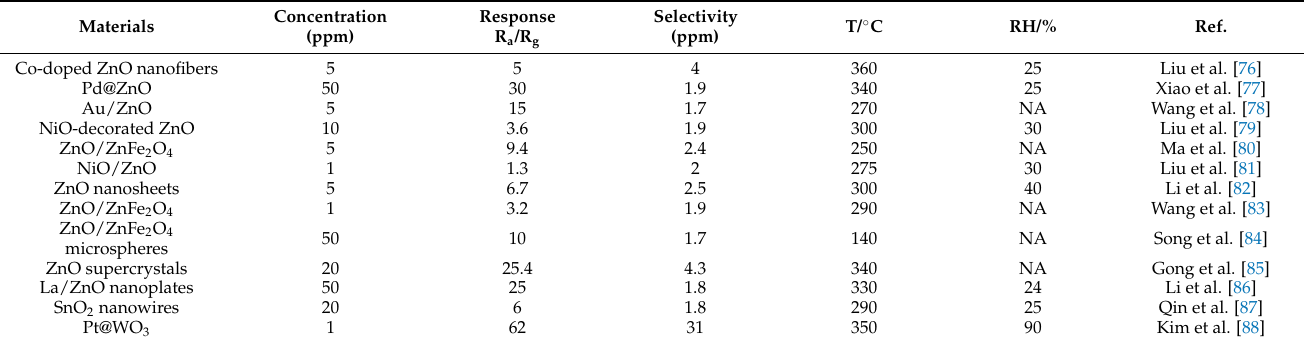
Table 3. Comparison of the selectivity, sensor response, and working temperature of the NM-based acetone gas sensor (effect of humidity is measured).